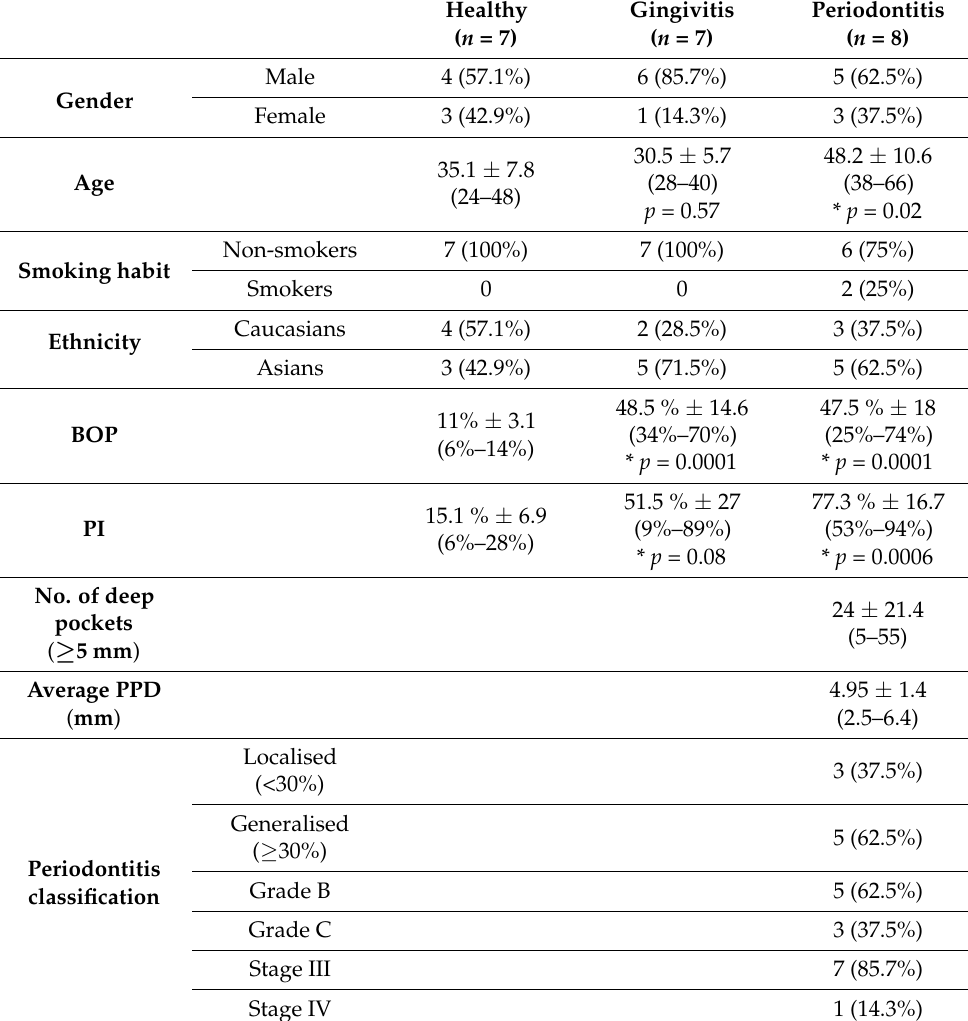
Table 1. Participants’ characteristics of the